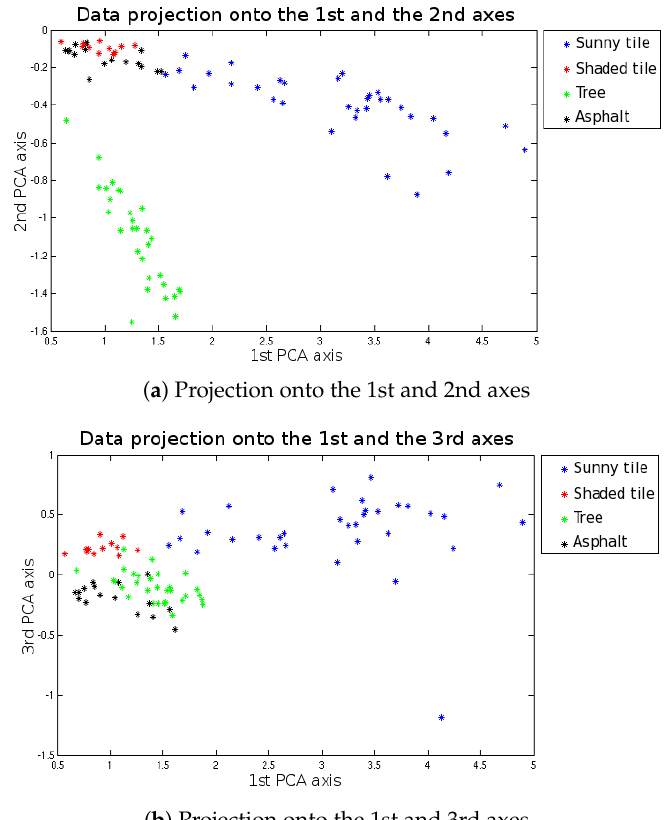
Figure 5. Projection on the first PCA axes of three extracted spectra classes: tile (blue and red dots), tree (green dots), asphalt (black dots). ( a ) projection onto the the first and second axes; ( b ) projection onto the first and third